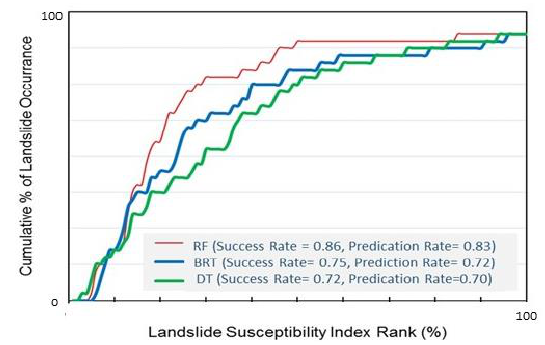
Figure 6: Success and prediction rates for the machine learning